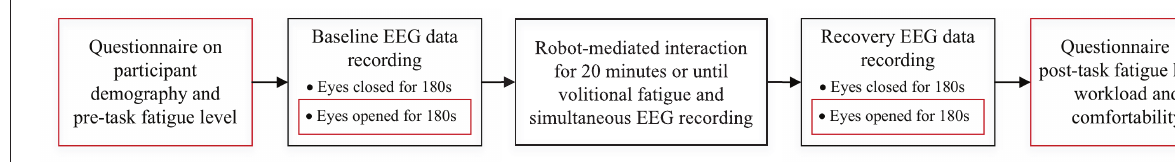
FIGURE 3 | Flow diagram of the proposed experiment.